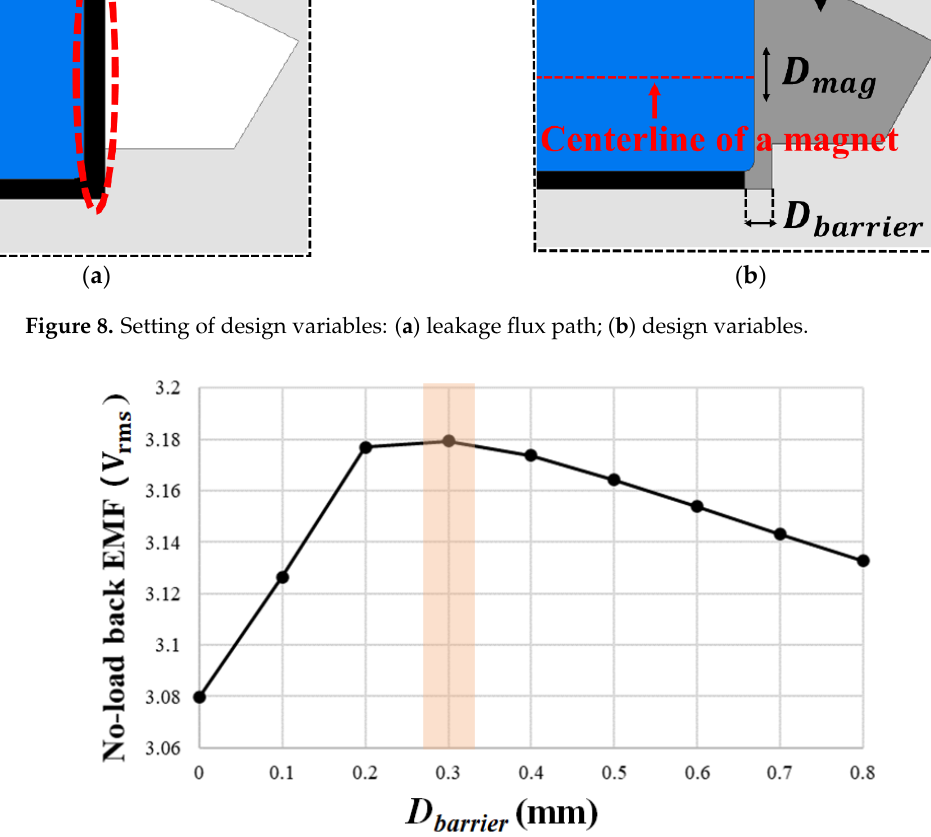
Figure 9. No-load back EMF variation with D barrier (4000 rpm).